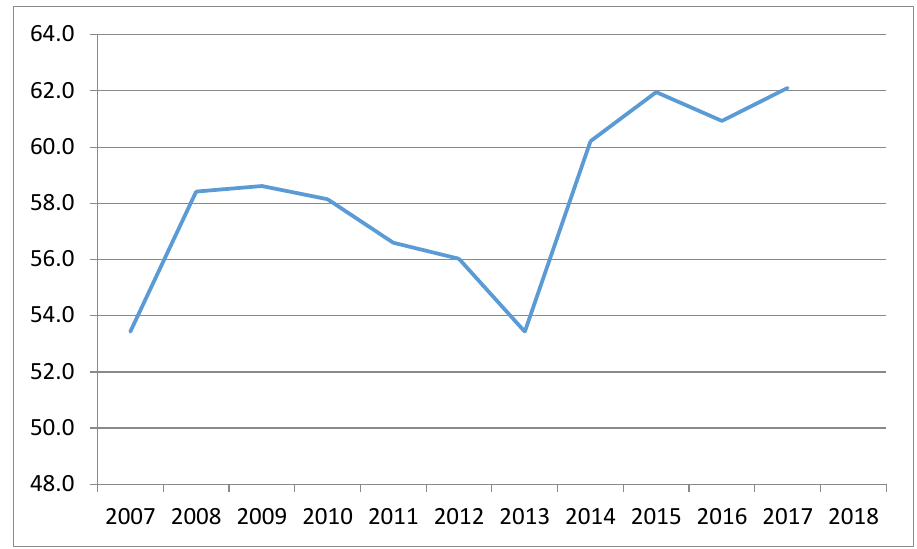
Figure 2. Average evolution of efficiency in the Eurozone countries (period of 2007–2018).